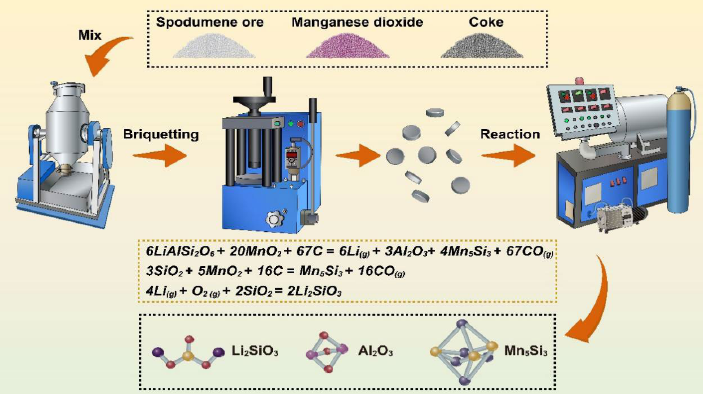
Figure 2. Schematic diagram of the reaction process. The raw materials were first mixed by a blender; then, the mixture was pressed into a round cake shape, entering the vacuum furnace for the preset experimental conditions.